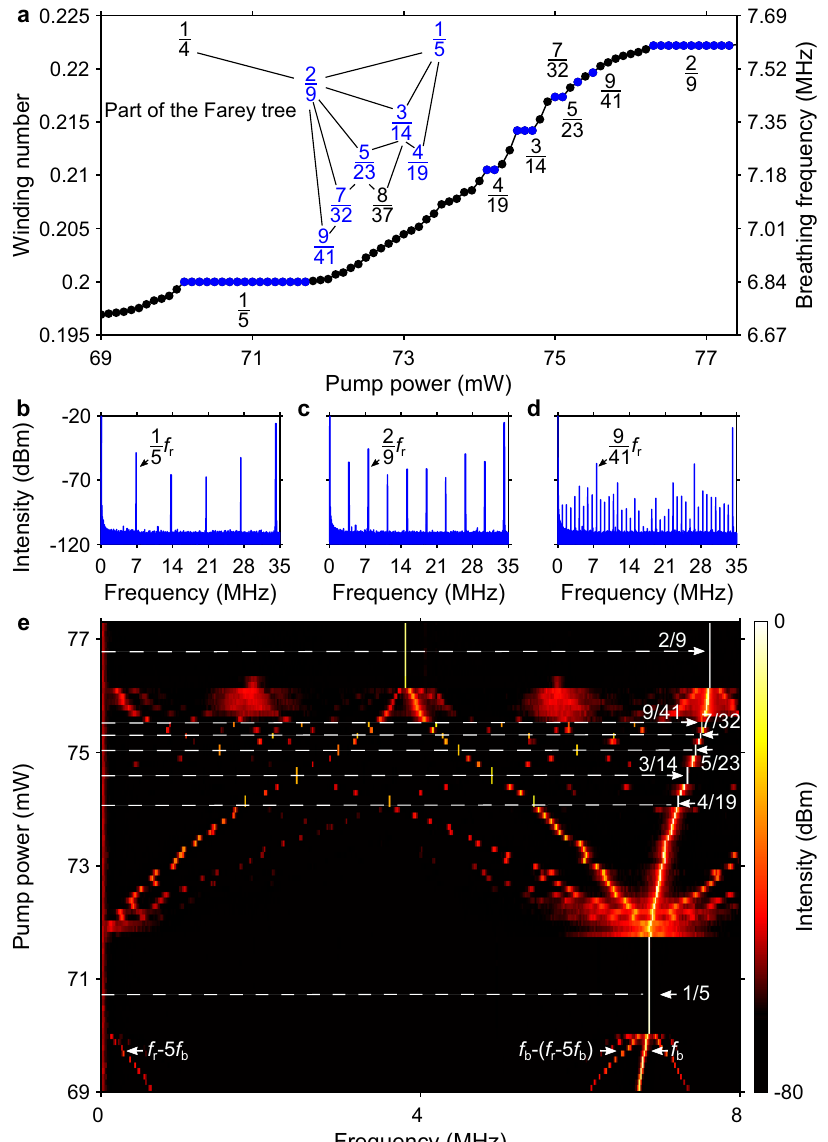
Fig. 5 | Farey tree and devil ’ s staircase measured in experiments. a Measured breathing frequency (winding number) as a function of the pump power. In the inset isshownthe part of the Farey tree containing the observed winding numbers (blue). b – d RF spectrameasured with the ESA showing dense frequencycombs for the frequency-locked states corresponding to the winding numbers 1/5, 2/9 and 9/